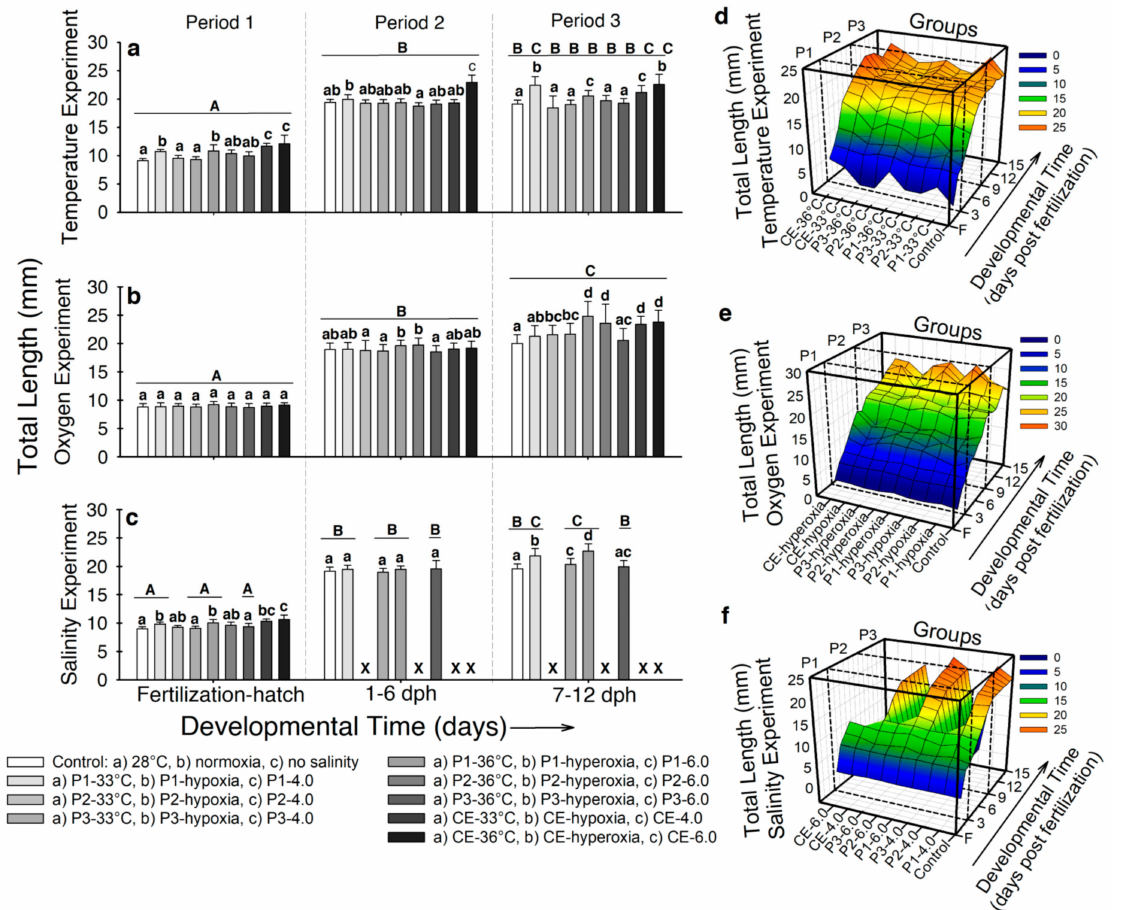
Figure 3. Total length (L T ) of Atractosteus tropicus at the end of each developmental period for the experiments with ( a ) temperature, ( b ) air saturation, and ( c ) salinity. Means ± SEM are presented. Lowercase letters represent differences between experimental groups from each developmental period ( p < 0.001). Capital letters indicate differences within developmental time for each experimental group ( p < 0.001). Panels ( d – f ) show the relation between development, treatments, and effect on the total length of the fish in the whole experiments for temperature, air saturation, and salinity, respectively. Control conditions: 28 ◦ C, 0.0 ppt of salinity, normoxia (95% air saturation); treatments 1: 33 ◦ C, hypoxia (~30% air saturation), or 4.0 ppt of salinity respectively to each experiment; treatments 2 (independently for each experiment): 36 ◦ C, hyperoxia (117% air saturation), or 6.0 ppt of salinity respectively to each experiment. Black crosses (X) in the salinity experiment represent groups where all fish died. n = 20 for each